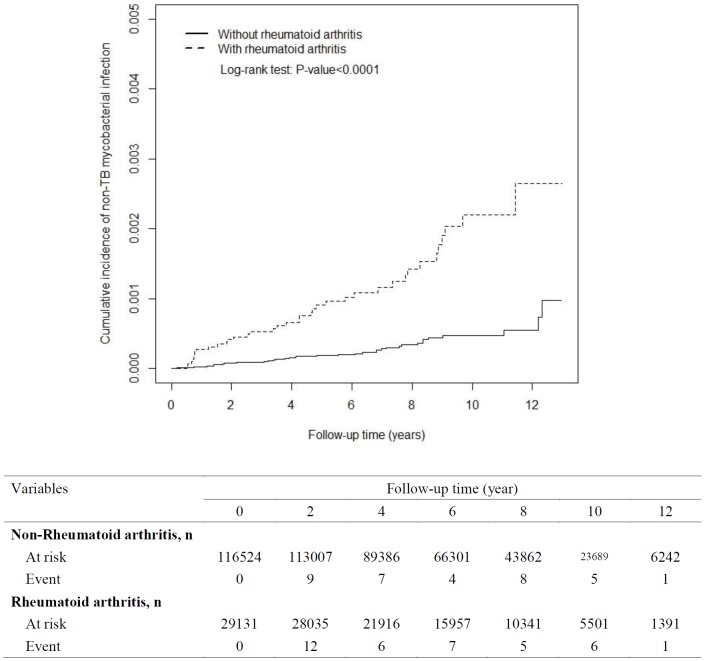
Cumulative incidence of non-TB mycobacterial disease for patients with rheumatoid arthritis (dashed line) and comparison subjects (solid line).